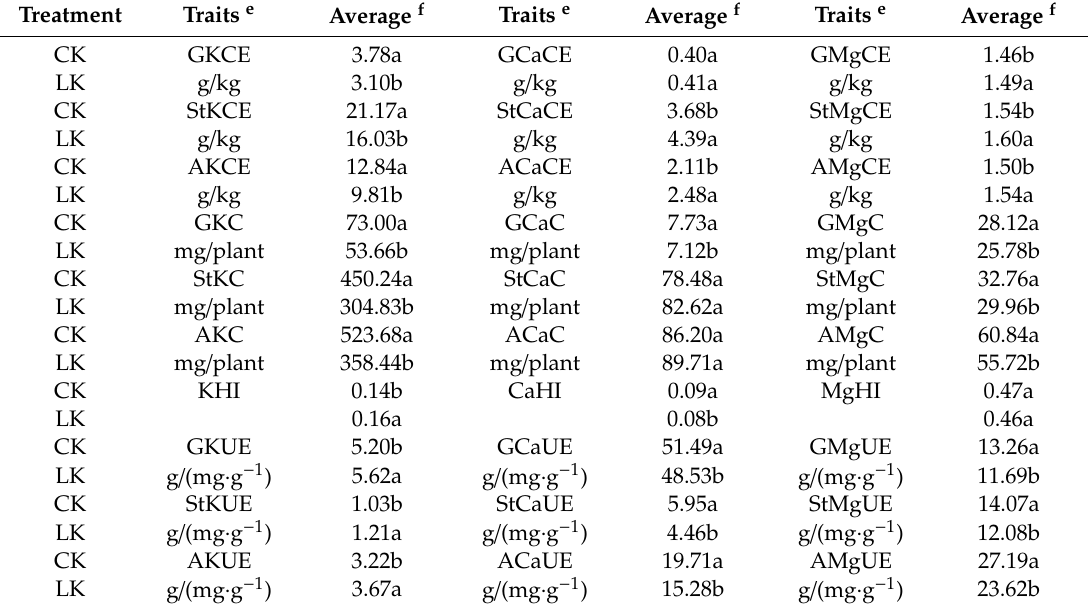
Table 3. Average values for the RILs for each treatment and trait of field